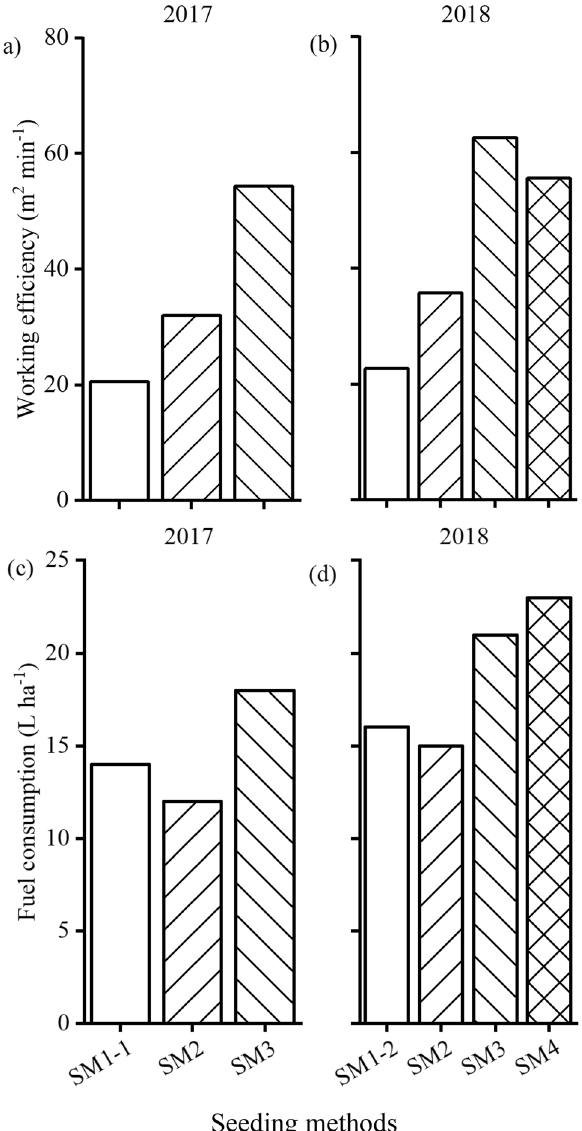
Figure 3. The working efficiency ( a and b ) and fuel consumption ( c and d ) of the different seeders in 2017 ( a and c ) and 2018 ( b and d ). SM1-1 small-size broadcast seeder, SM1-2 small-size drill seeder, SM2 small-size strip seeder, SM3 medium-size strip seeder, SM4 medium-size drill